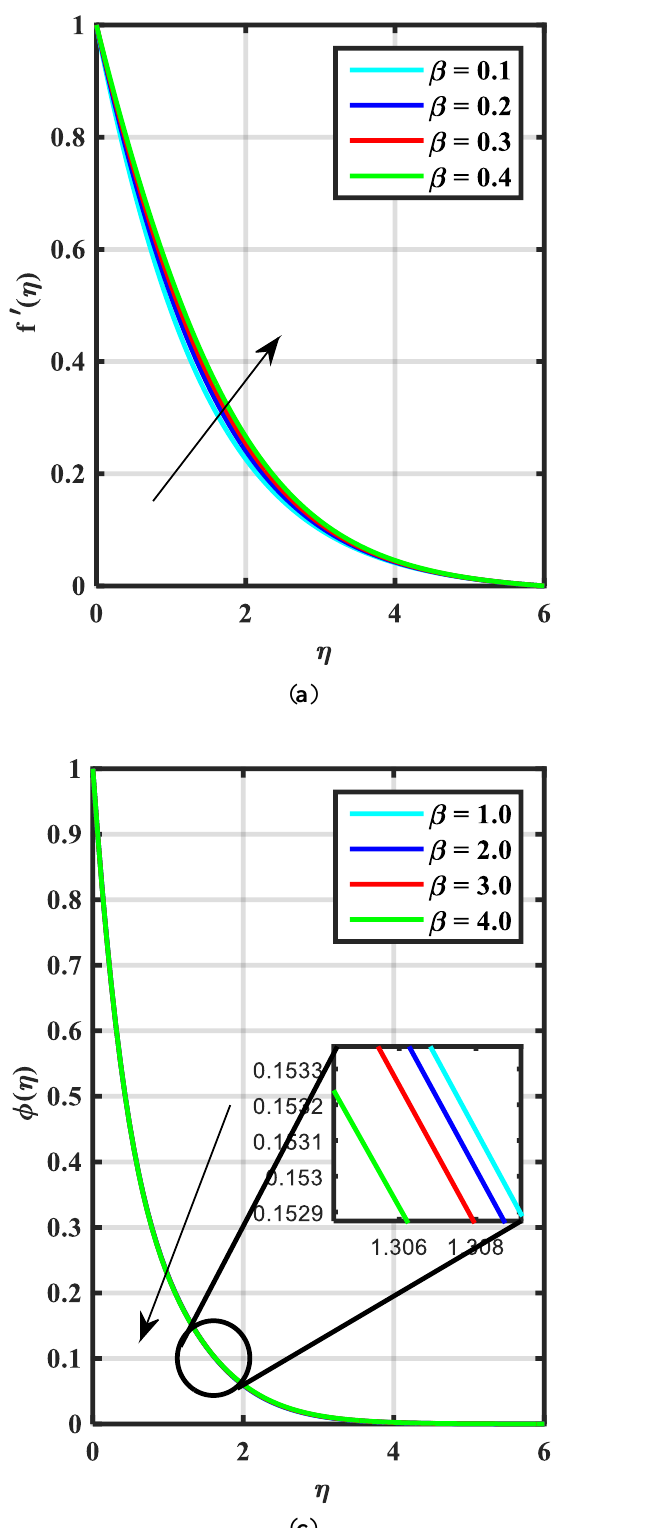
Figure 3. ( a – c ) Influence of 𝑓 ′ (𝜂), 𝜃(𝜂) 𝜙(𝜂) velocity over elastic parameter 𝛽 .